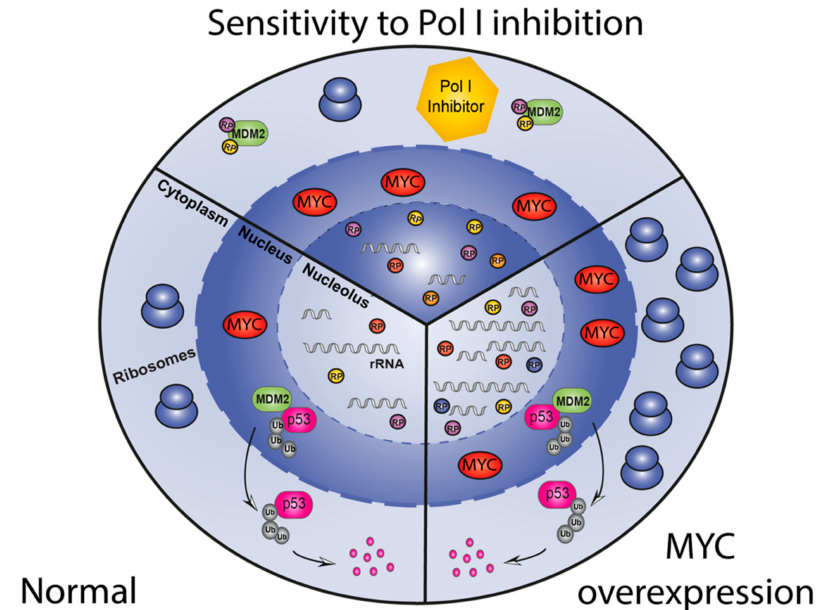
Figure 5. Schematic representation of the sensitization of MYC-overexpressing cancers to Pol I inhibition therapy. A cell with normal levels of MYC (left) maintains physiological levels of rRNA and RP and therefore produce adequate levels of ribosomes. Overexpression of MYC in cancer cells (right) causes increases of both rRNA and RP allowing for an increased number of ribosomes necessary to maintain uncontrolled growth and proliferation. Therapy with Pol I transcription inhibitors (top) leads to a reduction in rRNA levels while RP levels are maintained at a high level due to the e ff ect of MYC on Pol II transcription. Excess free RP can then activate the NSP, allowing the stabilization of p53 and consequently promotes cell cycle arrest or